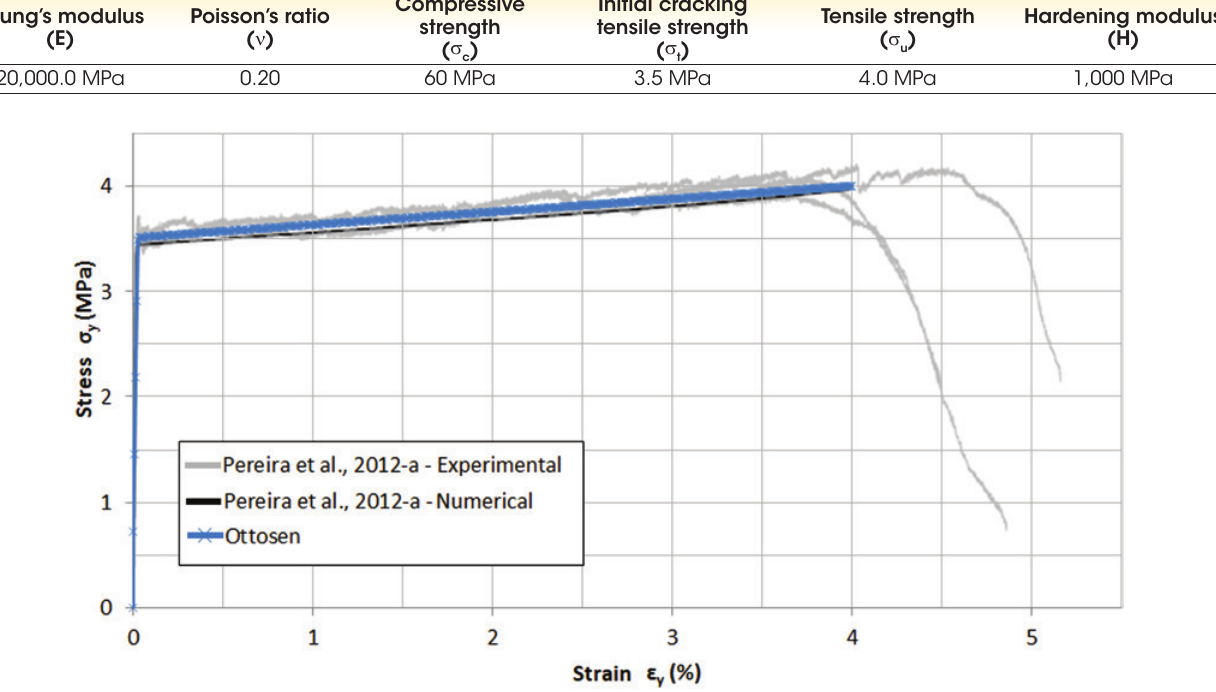
Table 3 Material parameter of Dogbone-shape panel Young’s modulus (E)